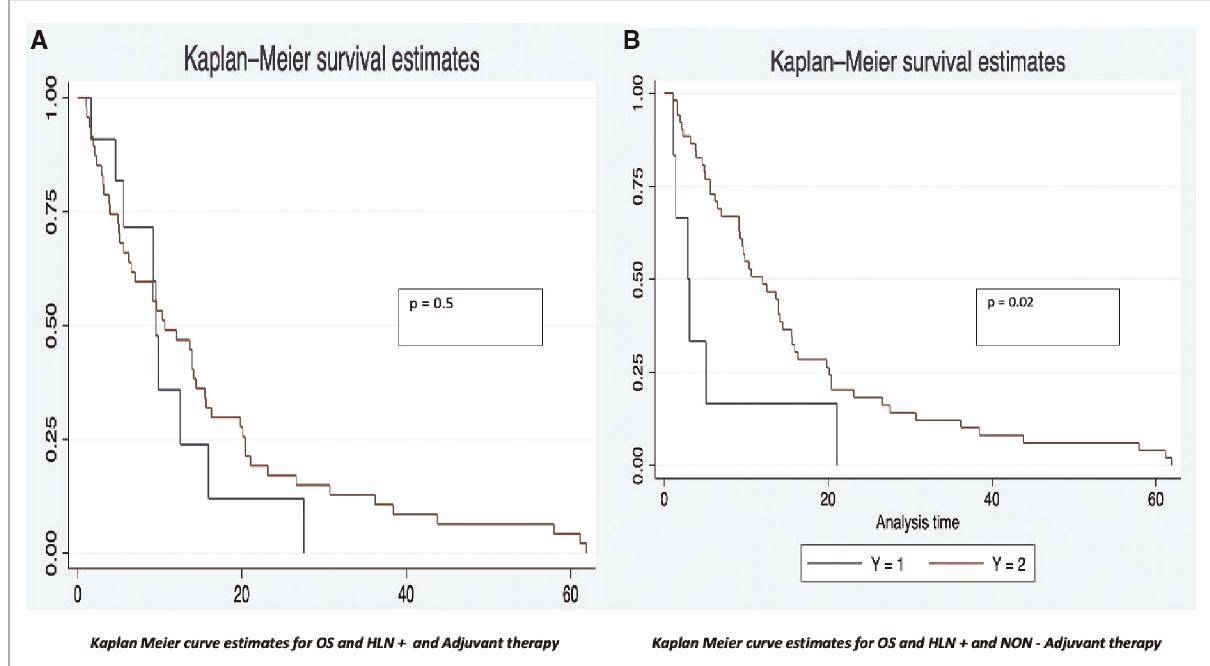
FIGURE 3 Kaplan meier curve estimates for OS (HLN +/ − vs. Chemo/Non chemotherapy groups).